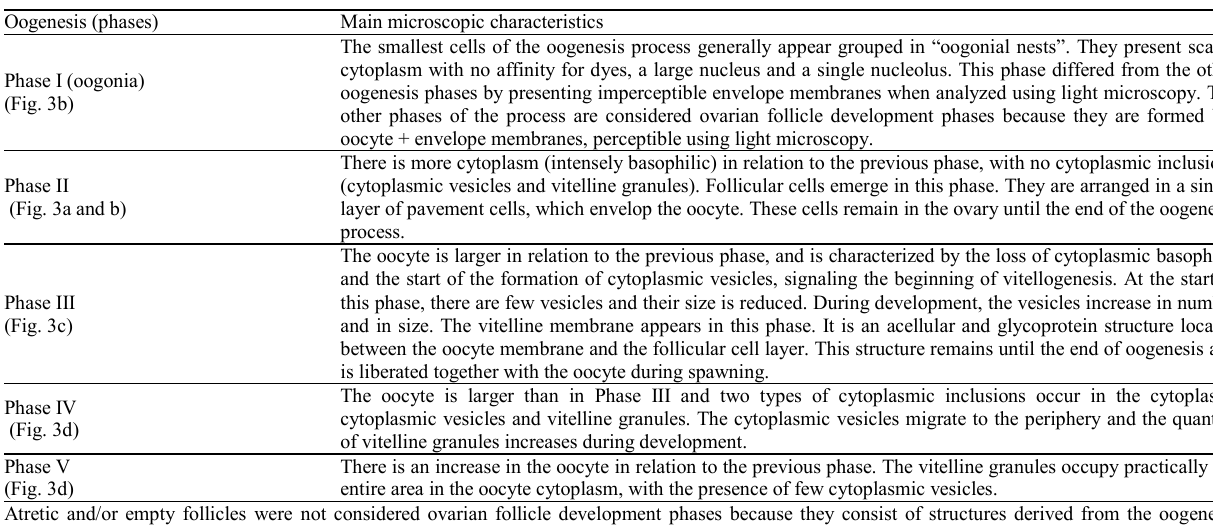
Table 1. Microscopic description of the main morphological characteristics that determine the oogenesis phase of Etropus crossotus , obtained in the shallow infralittoral areas of the Paranaguá Estuarine Complex.